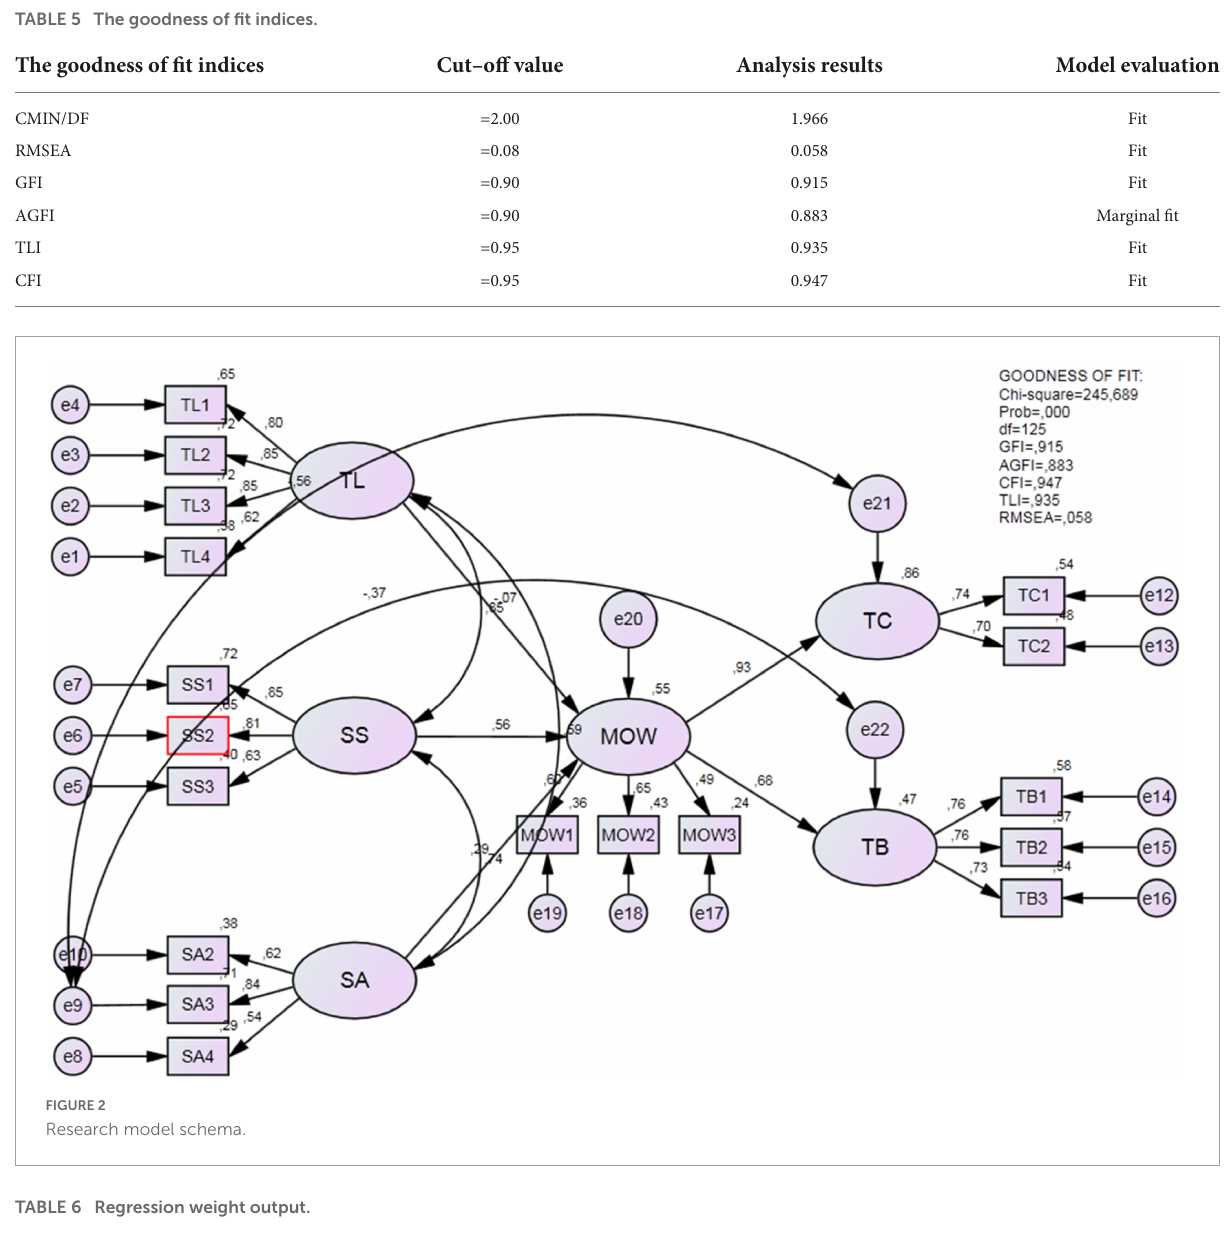
TABLE 5 The goodness of fit indices.